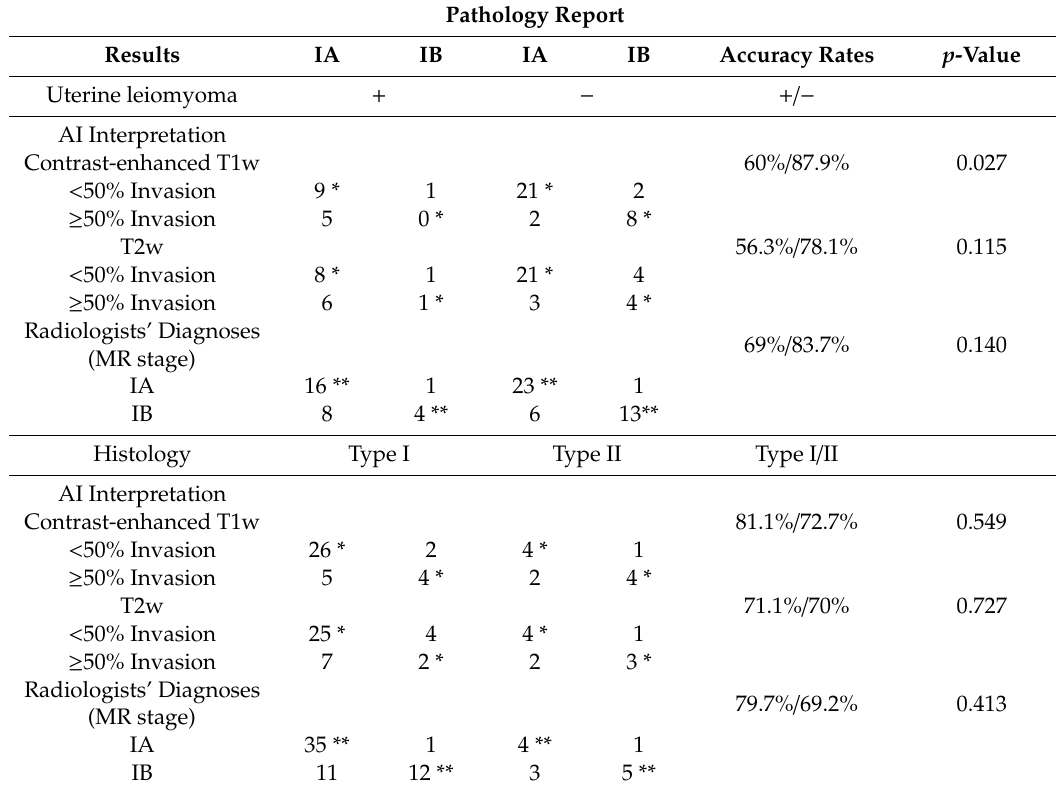
Table 3. Influence of concomitant conditions on the accuracy rates of AI and